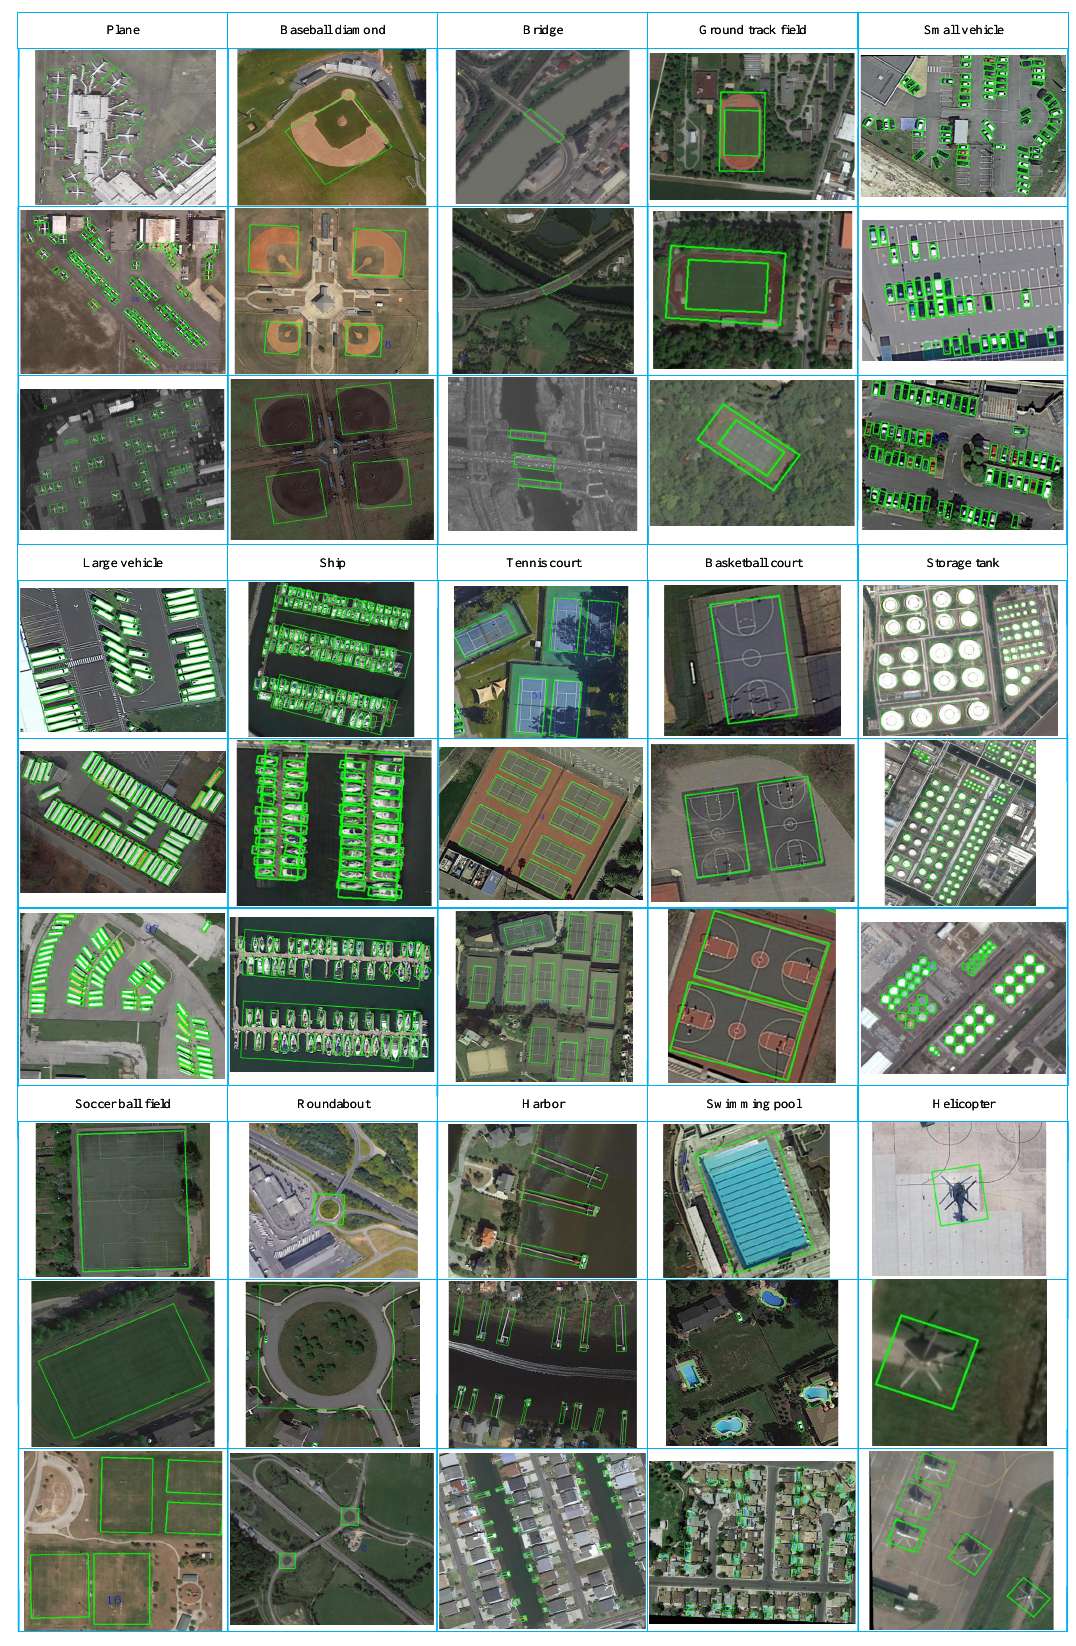
Figure 8. Visualization of detection results of proposed MFIAR-Net on OBB task of